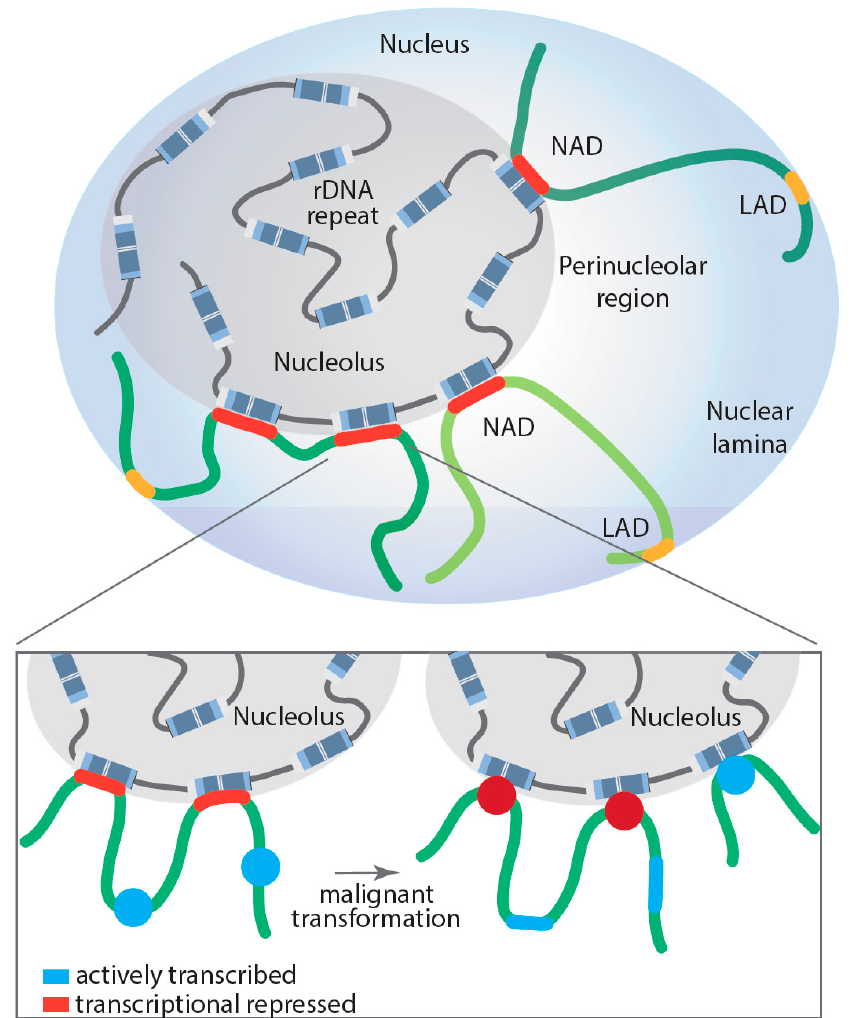
Figure 2. Proposed model of dynamically regulated long-range rDNA–NAD interactions during malignant transformation and their impact on Pol II-dependent transcription at associated loci. Lamina-associated domain (LAD); nucleolus associated domain (NAD); red: transcriptionally re- pressed Pol II-dependent genes; blue: actively transcribed Pol II-dependent genes.